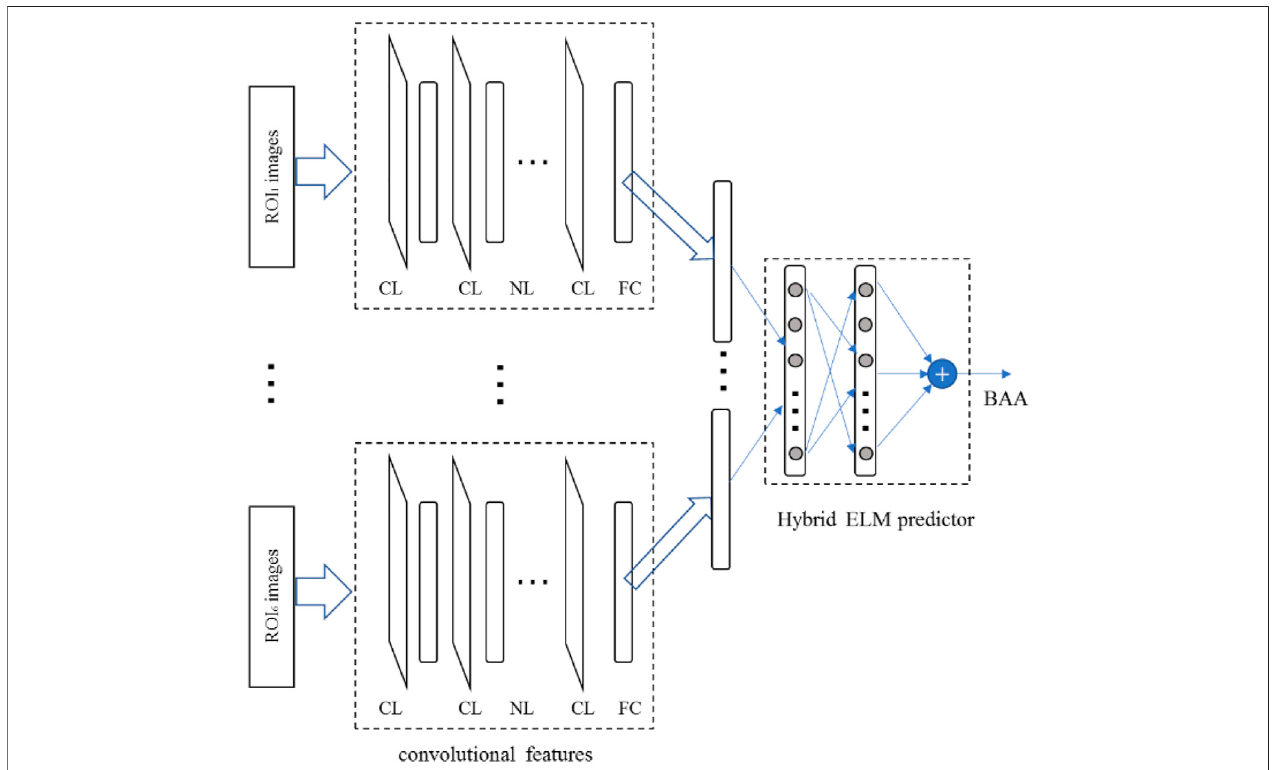
FIGURE 3 | Architecture of the proposed bone age prediction